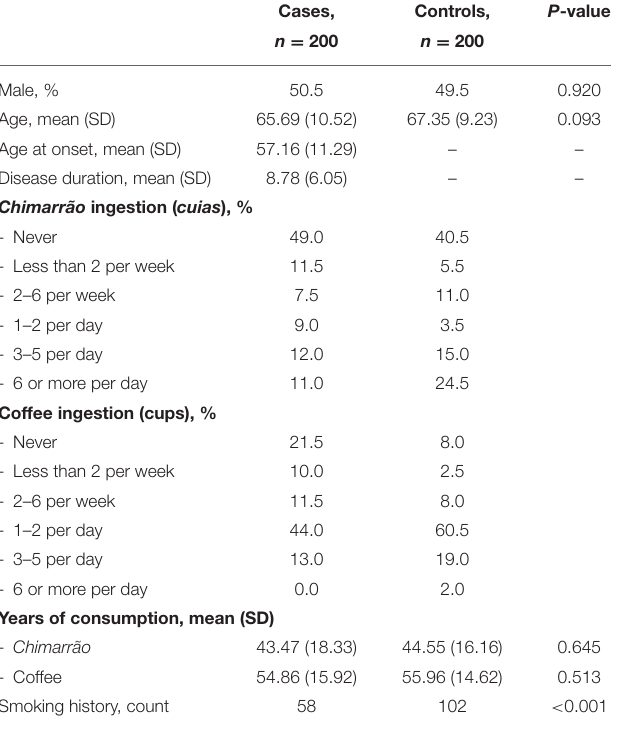
TABLE 1 | Demographic data of cases and control subjects.